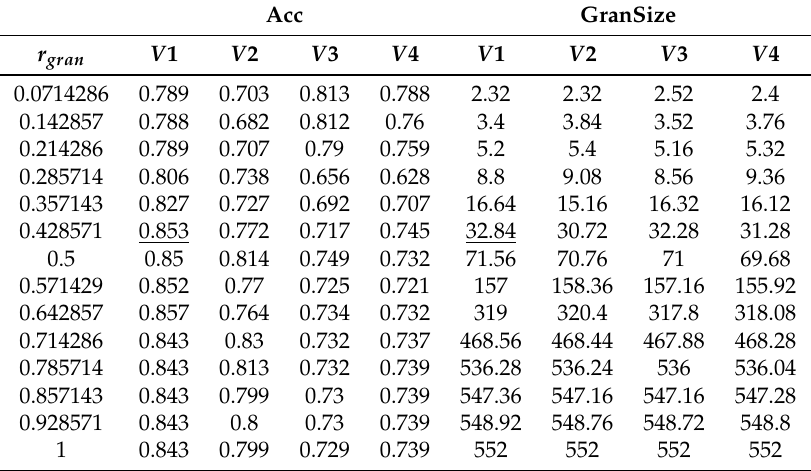
Table 21. 5 × CV-5; The result of experiments for four variants of the Naive Bayes classifier; data set Australian credit; concept dependent granulation; r gran = Granulation radius; nil = result for data without missing values; Acc = Accuracy of classification; GranSize = The size of data set after granulation in the fixed r .